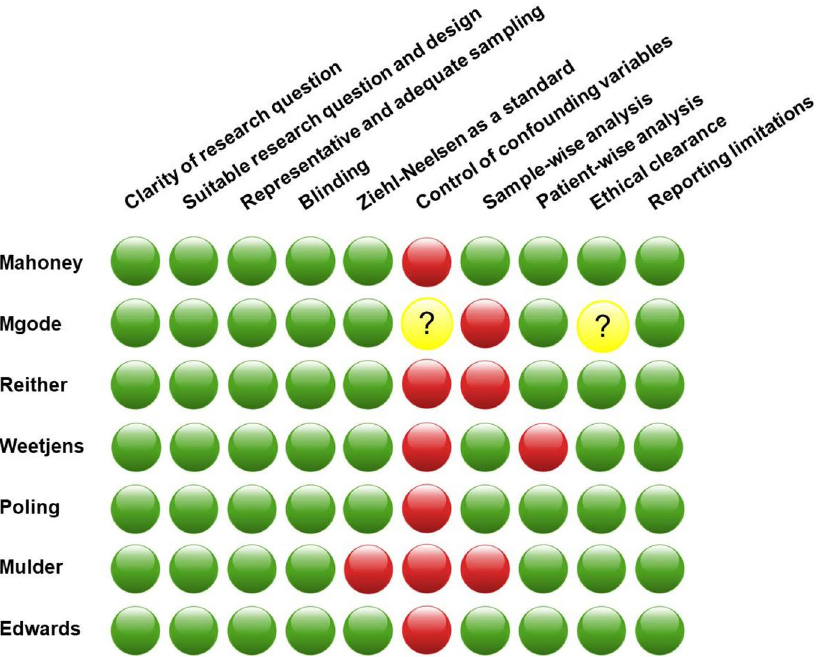
Figure 6. The quality of each study was assessed by answering questions concerning the clarity of research, blindedness, representative and adequate samples, control of confounding variables, research design suitable to answer the research question, ethical clearance, reporting overall sensitivity percentage, reporting overall specificity percentage, and reporting limitations. The presence of non-mycobacterial species in addition to failure to report HIV status were deemed confounding factors. Green = yes; yellow = unclear; red =